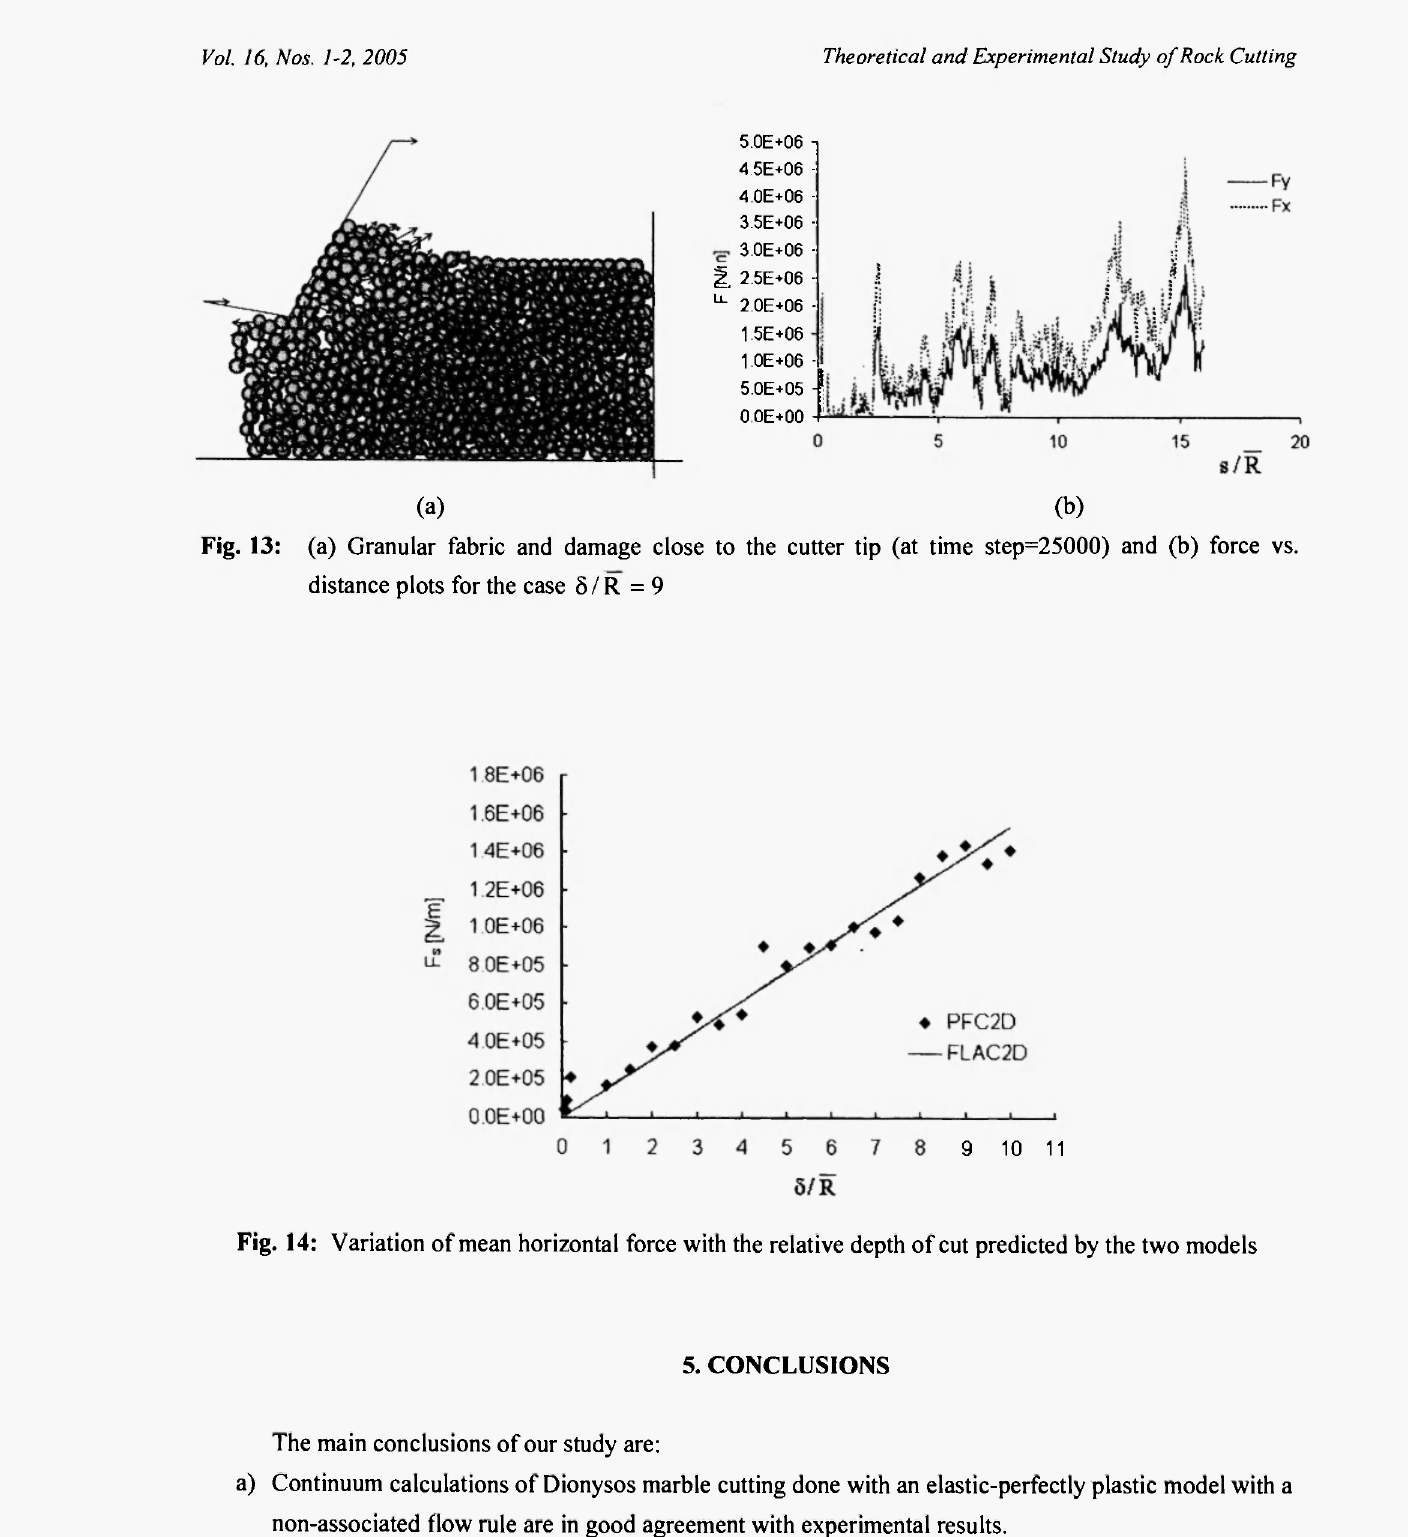
Fig. 14: Variation of mean horizontal force with the relative depth of cut predicted by the two